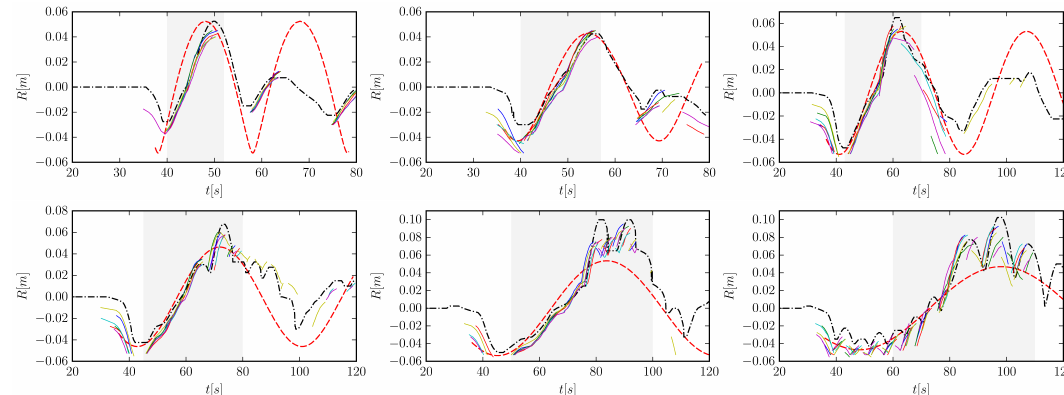
Figure 7. Time series of run-up elevation R from the experiments and the numerical simulation using experimental boundary data for all six wave shapes (left to right: T20_H2, T30_H2, T44_H3 (top row ); T58_H3 (bottom left ); T77_H4, T100_H4 ( bottom row )). Depicted are the theoretical evolution for periodic sinusoidal waves (red dashed), the numerical simulation (black dash-dotted) and the results from the six experimental measurements (solid lines). The shaded regions depict the intervals where the extreme values for the diagrams in Figure 9 were